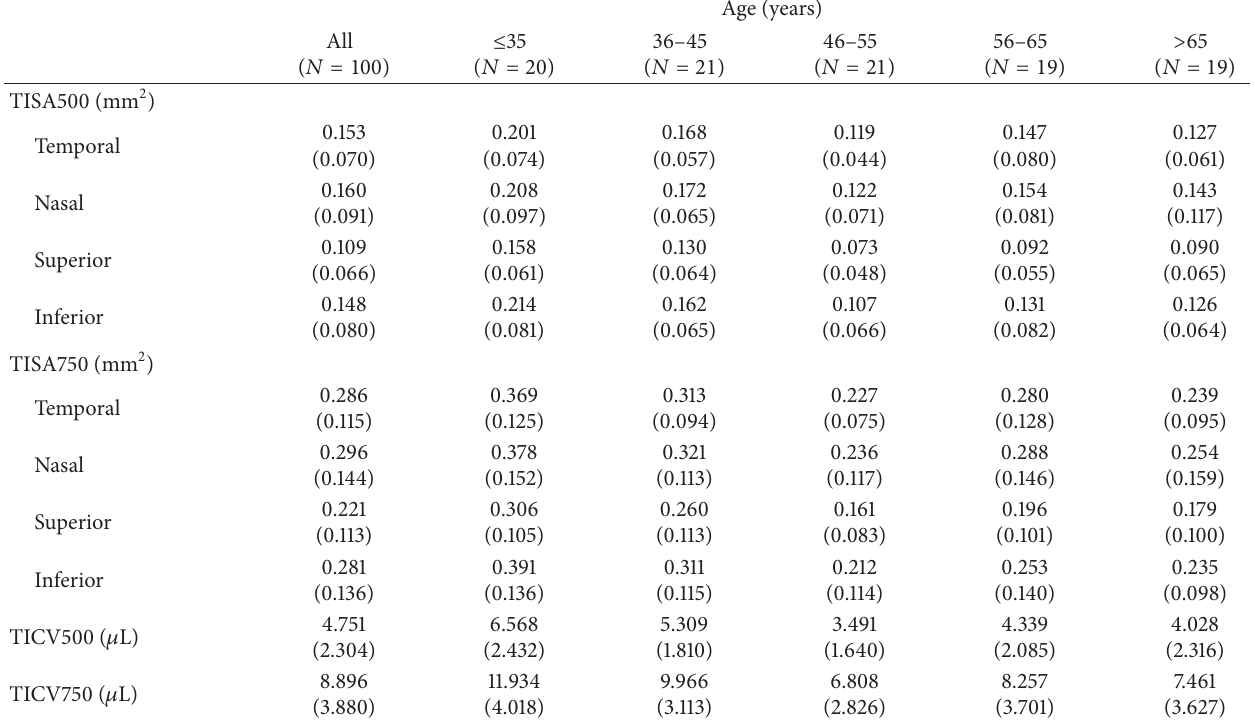
Table 2: Angle measurements [mean (SD)] for all eyes and for eyes in each age